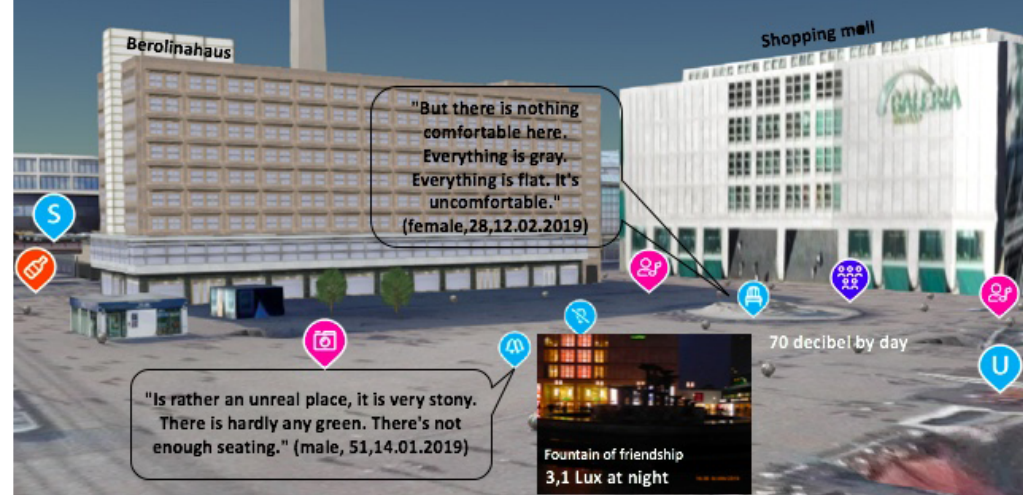
Figure 7. Hybrid map of security perception in public areas. Source: VirtualCitySystems